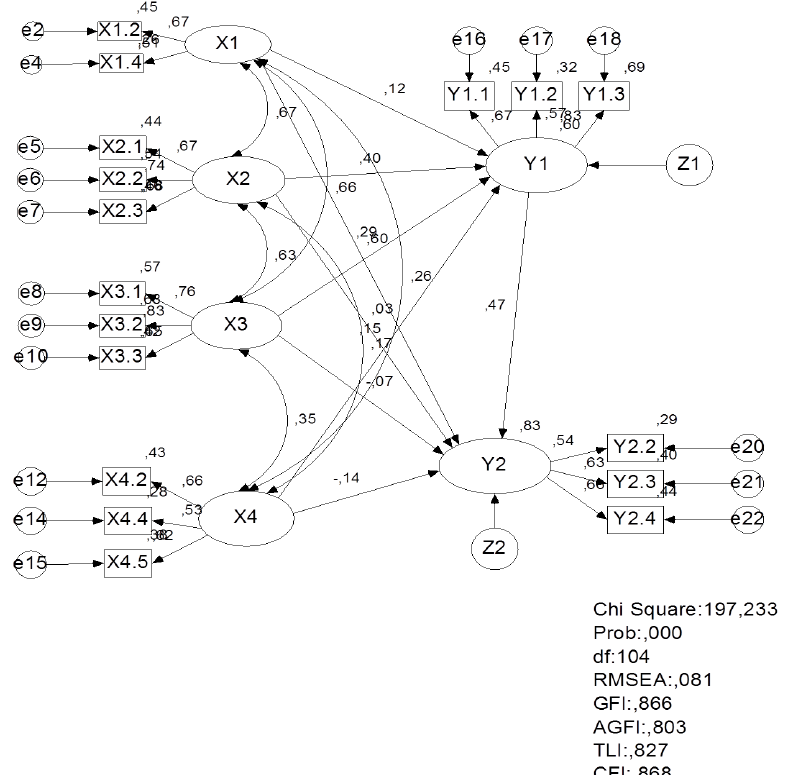
Figure 2. Results of early-stage SEM analysis